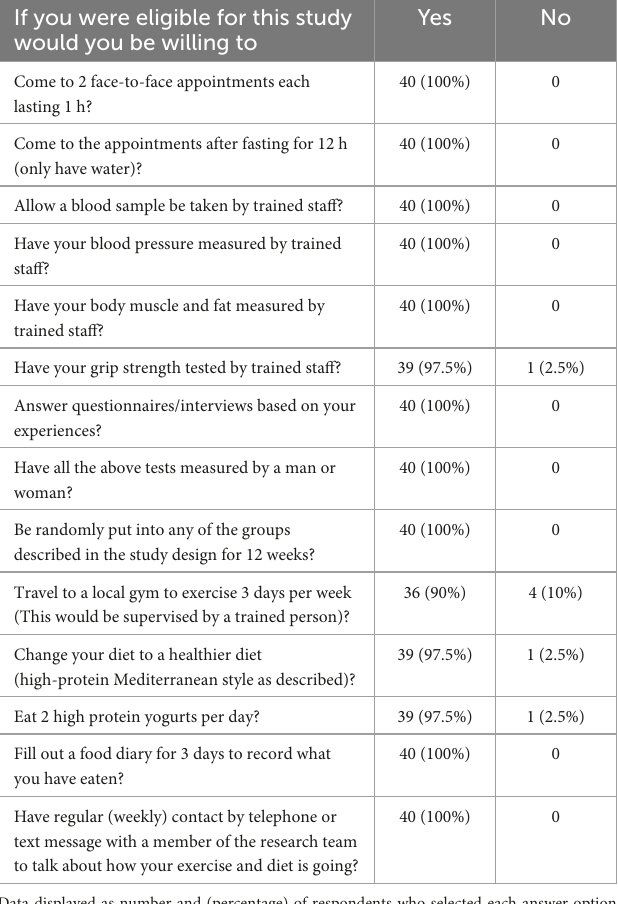
TABLE 2 Participant responses to questions relating to intervention protocol